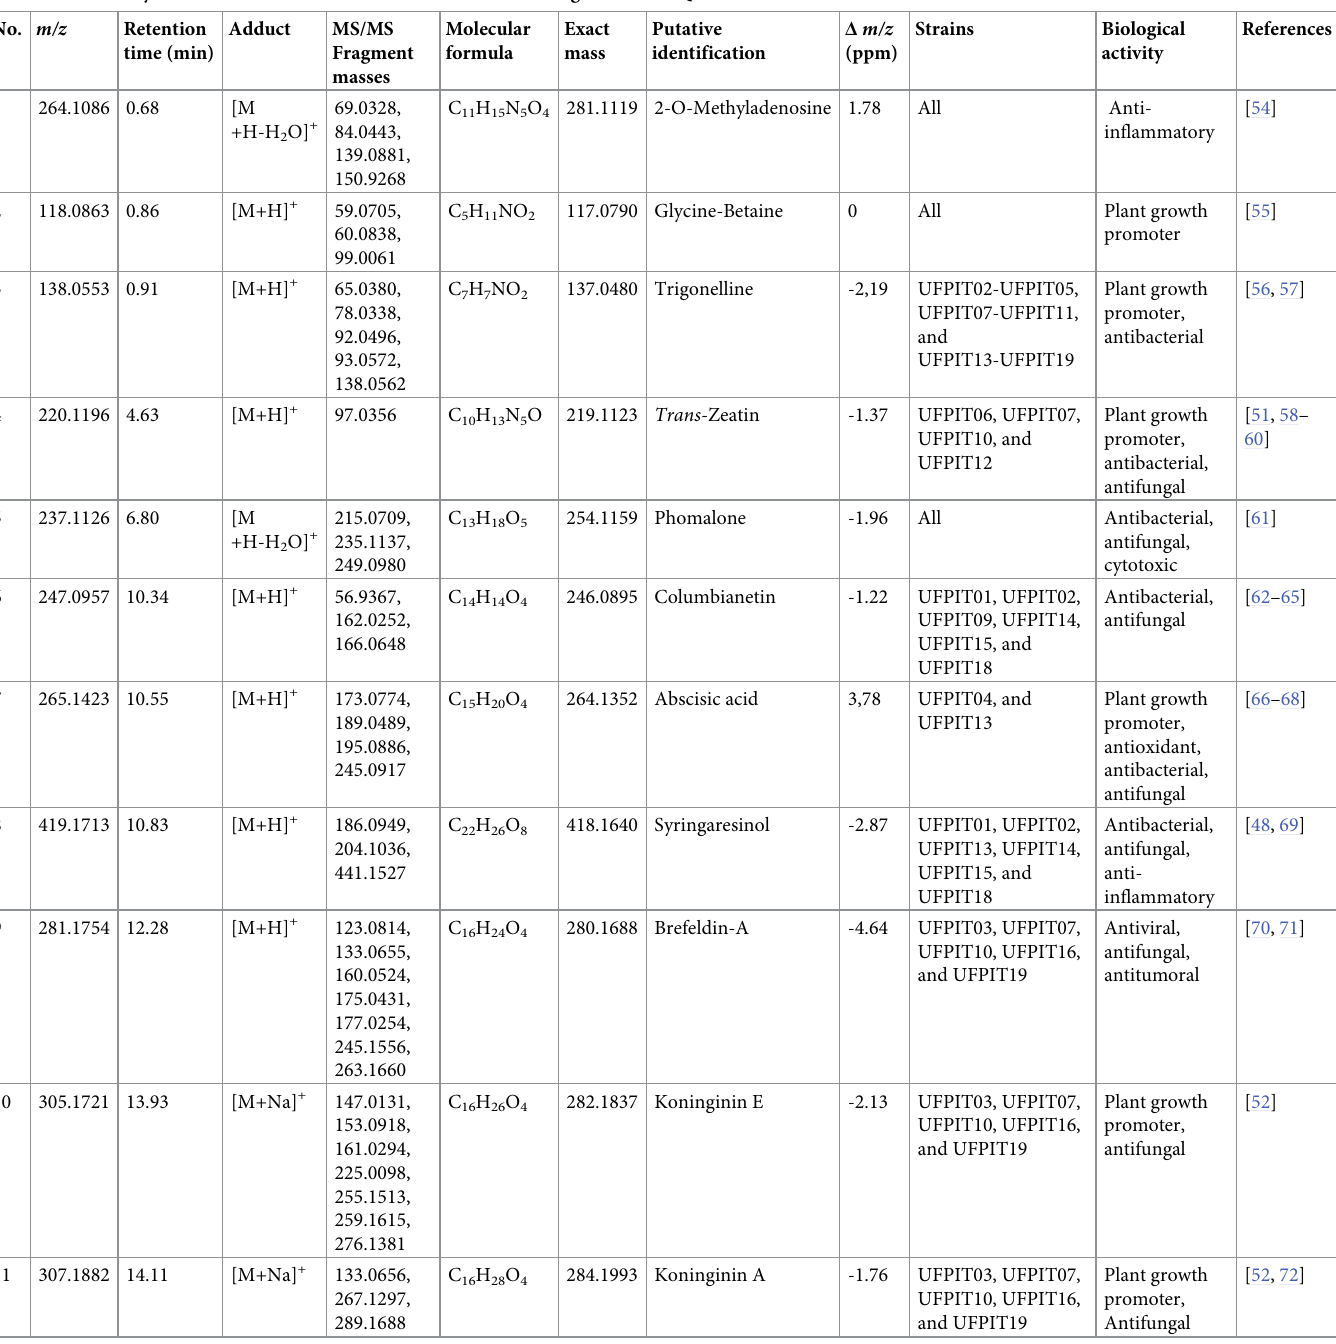
Table 1. Secondary metabolites identified in Trichoderma strains using UPLC-ESI-Q-TOF-MS. No. m/z Retention time (min)